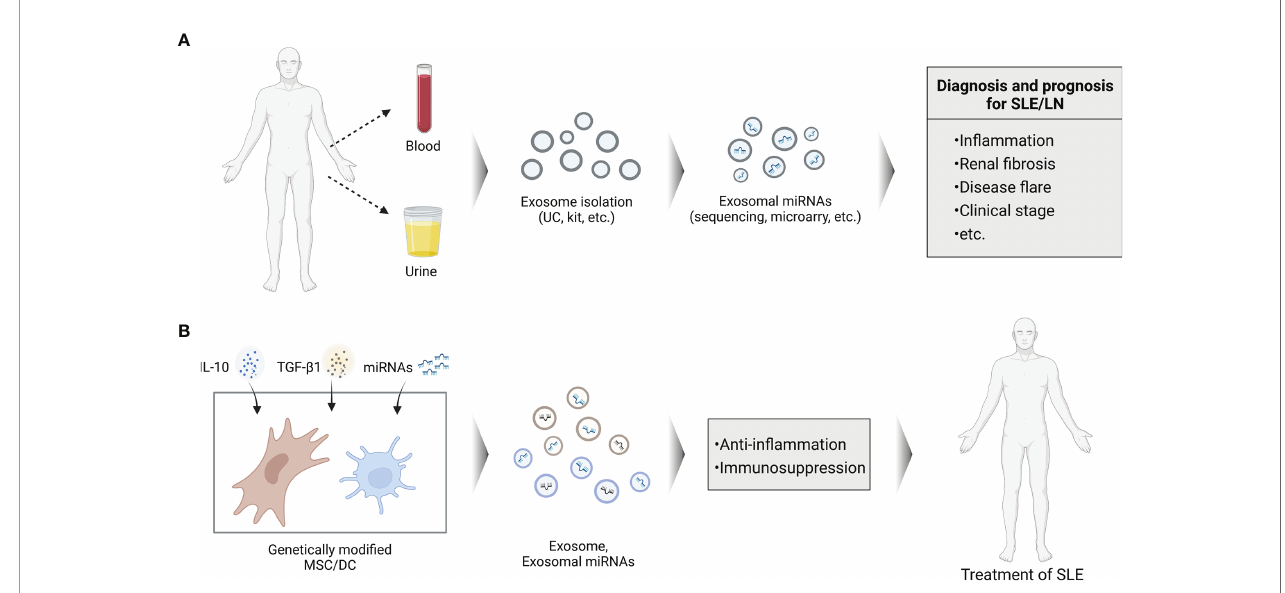
FIGURE 3 | Schema of potential roles of exosomal miRNAs in SLE. (A) Analysis of exosomal miRNAs isolated from blood or urine can be used for the clinical diagnosis and prognosis of SLE. (B) Genetically modi fi ed cells to secrete exosomes containing speci fi c miRNAs can be used as cell-free agents of